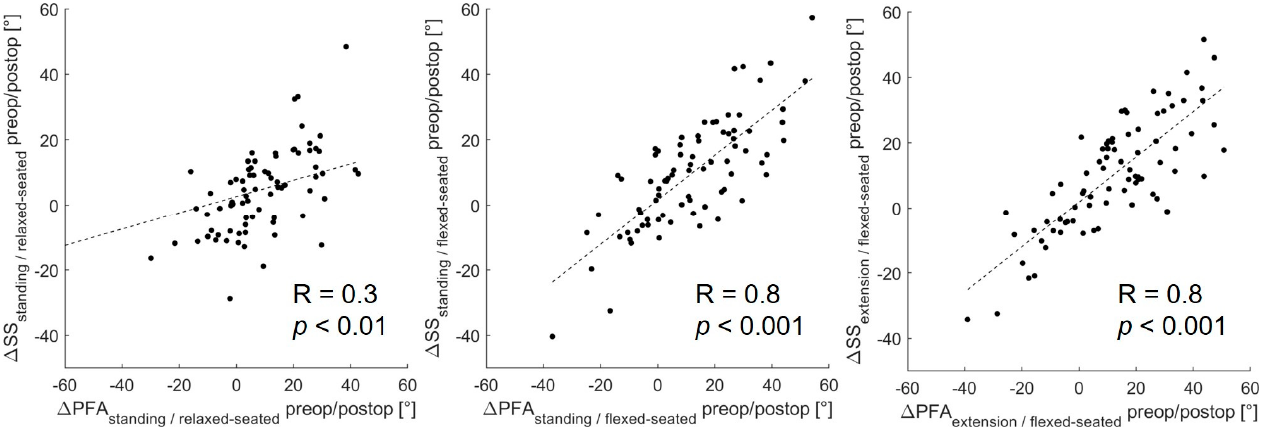
Figure 3. Correlation between the change of Δ PFA and Δ SS between preoperative and 12 months postoperative form standing or extension to relaxed- or flexed-seated position.